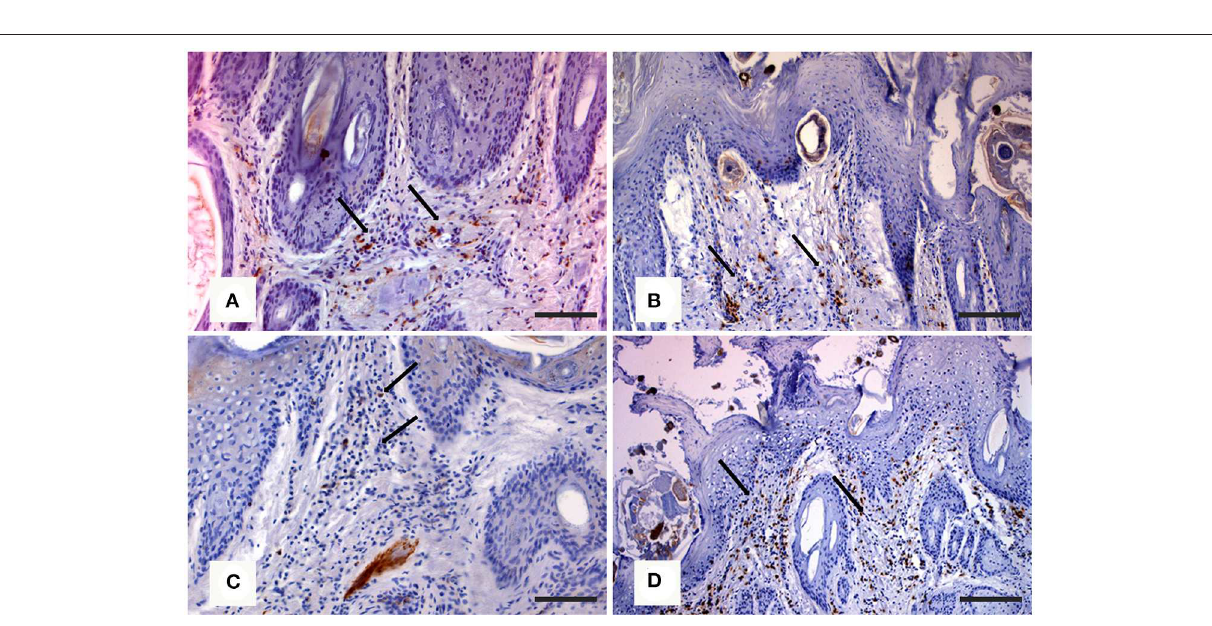
FIGURE 4 | Immunohistochemical staining of skin in northern chamois ( Rupicapra r. rupicapra) affected by sarcoptic mange. The following pictures are further evidenced by black arrows: (A) Diffuse macrophages infiltration in the superficial dermis in grade 2 sarcoptic mange (IHC, anti CD68 antibody, DAB chromogen, and hematoxylin counterstain, bar = 300 µ m). (B) Numerous T lymphocytes in the superficial dermis of a chamois with grade 2 sarcoptic mange (IHC, anti CD3 antibody, DAB chromogen, and hematoxylin counterstain, bar = 300 µ m). (C) Increased B lymphocytes infiltration in the superficial dermis in a grade 3 sarcoptic mange (IHC, anti CD79a antibody, DAB chromogen, and hematoxylin counterstain, bar = 300 µ m). (D) Scattered T lymphocytes among B cells in a grade 3 lesion (IHC, anti CD3 antibody, DAB chromogen, and hematoxylin counterstain, bar = 300 µ m). Further details available in Salvadori et al.